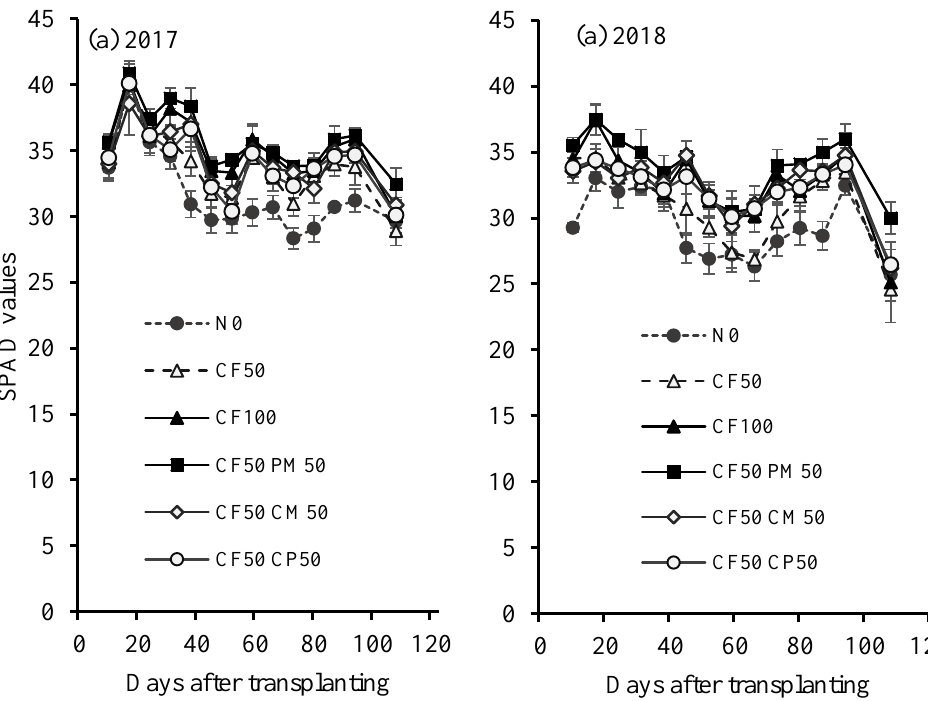
Figure 3. Changes in soil–plant analysis development (SPAD) values of rice variety Manawthukha affected by organic fertilizers. Vertical bars represent the SD of three samples .